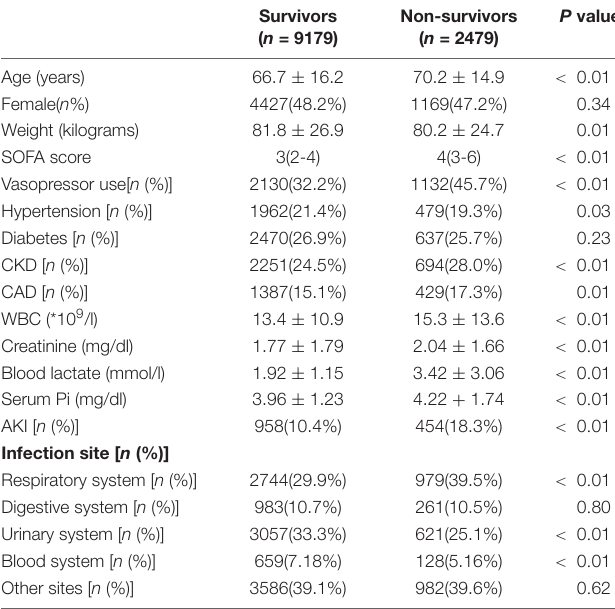
TABLE 1 | Comparisons of demographics between survivors and